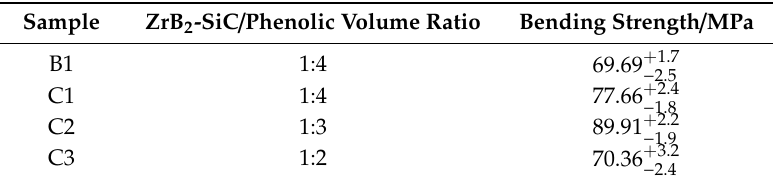
Table 3. Bending strength of the ZrB 2 –SiC-modified phenolic composites.